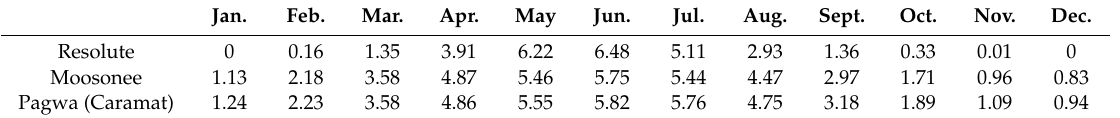
Table 5. Solar insolation (kWh / m 2 / h) of Resolute, Moosonee, and Pagwa [82].